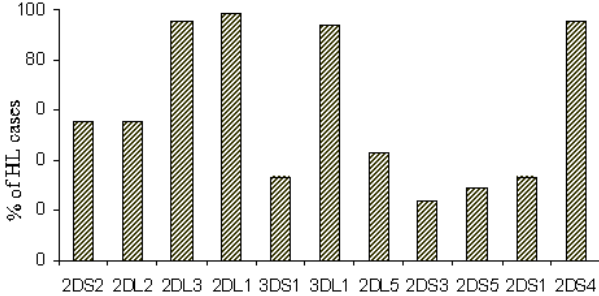
Figure 2. Phenotypic distribution of KIRs in Hodgkin’s lymphoma cases. The proportion (percentages) of present KIR genes, as de- termined by KIR gene content analysis are presented for the index HL cases (n=90). Eleven KIR genes are presented in the figure. Two pairs of KIR genes are allelic: KIR3DL1/3DS1, and KIR2DL2/2DL3 .